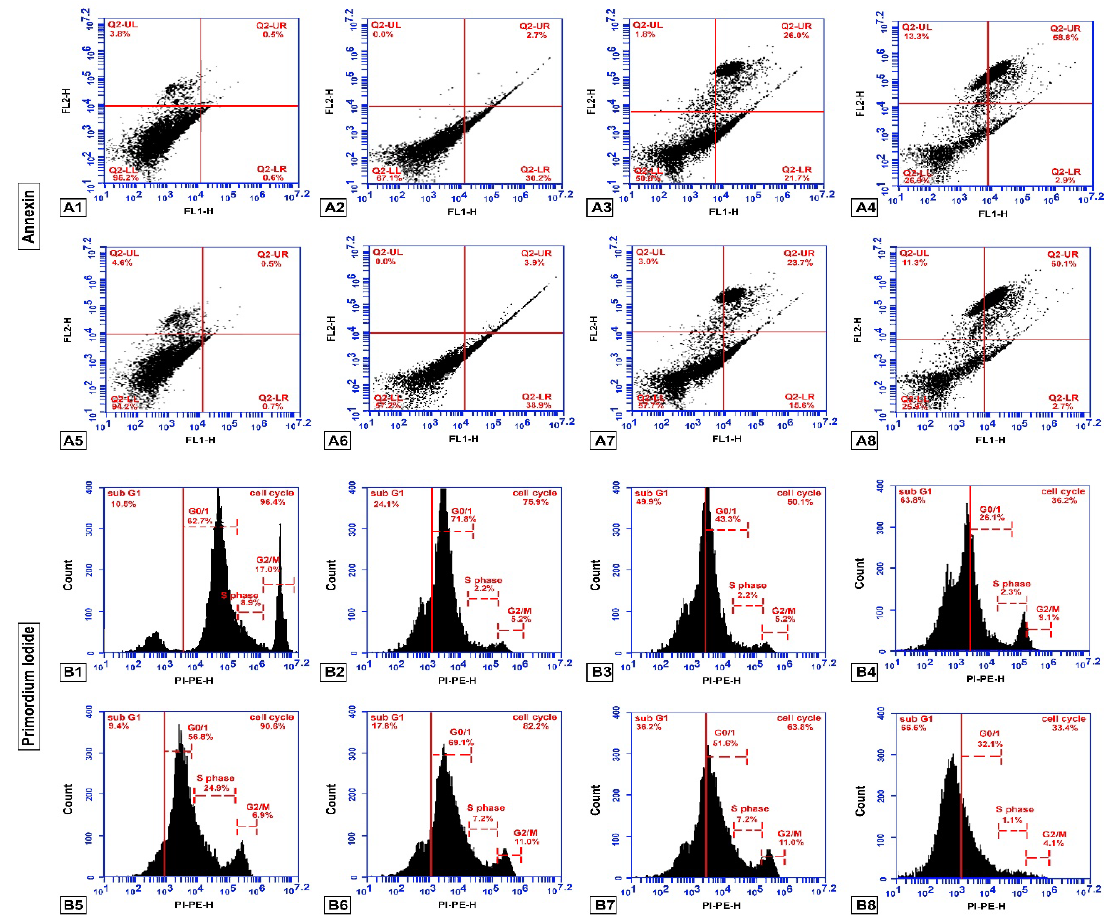
Figure 3. Flow cytometry analysis of negative control cells acquired without stain for: ( a ) annexin and ( b ) promidium iodide.